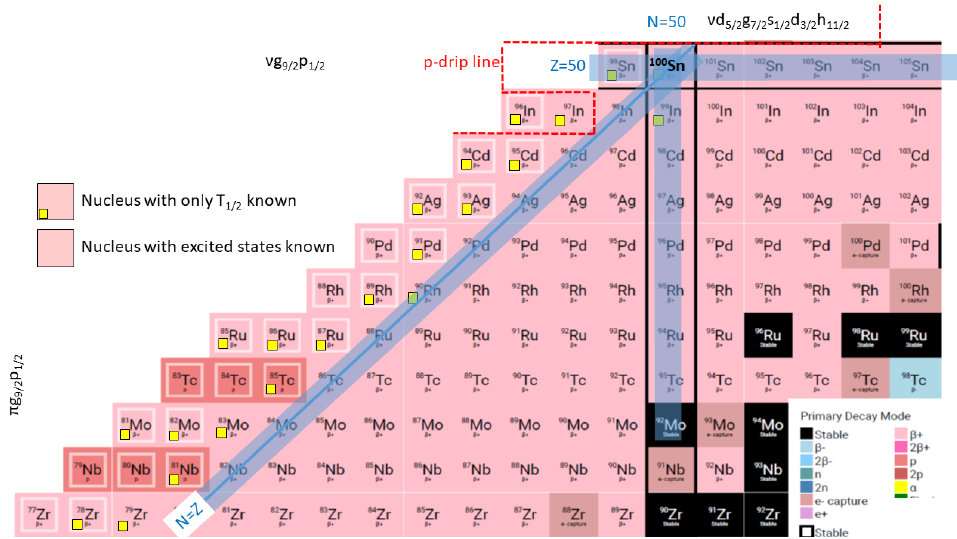
Figure 1. Present status of experimental information on the ground-state lifetime and excited states in the 100 Sn region. Nuclei with only the ground-state lifetime known and no excited states reported are indicated with a small yellow square. The nuclei to the left of them were only produced in an experiment. The blue-shaded chains of nuclei highlight the main focus of this review.